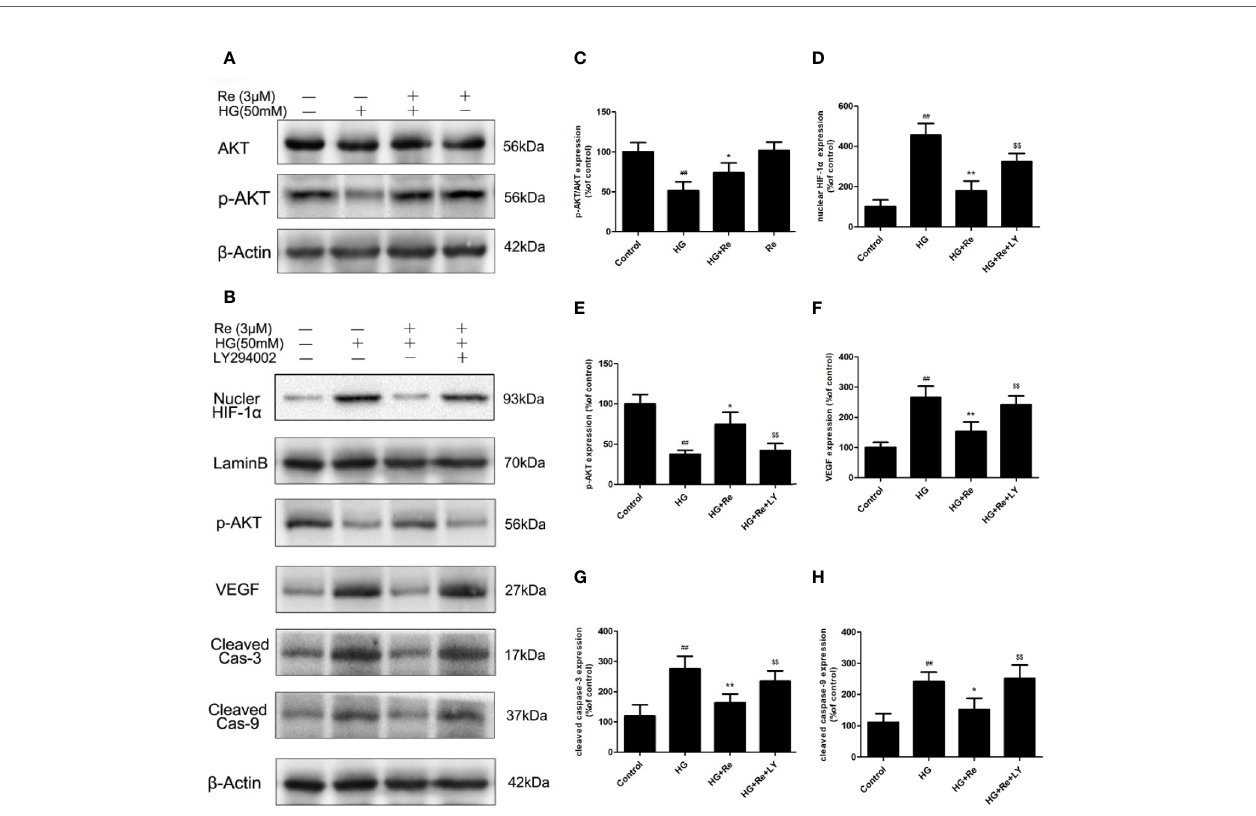
FIGURE 7 | Re protects RF/6A cells via regulation of the PI3K/Akt pathway. (A) Akt and p-AKT expression detected by western blot. (B) The changes of related proteins after LY294002 (PI3K inhibitor) incubation. (C) Analysis of Akt and p-Akt expression. (D – H) Statistic analysis of related protein levels. The results are presented as the mean ± SEM percentage of the control from three independent tests. ## P < 0.01 versus the control group; *P < 0.05, **P < 0.01 versus the HG group; $$ P < 0.01 versus the HG+Re